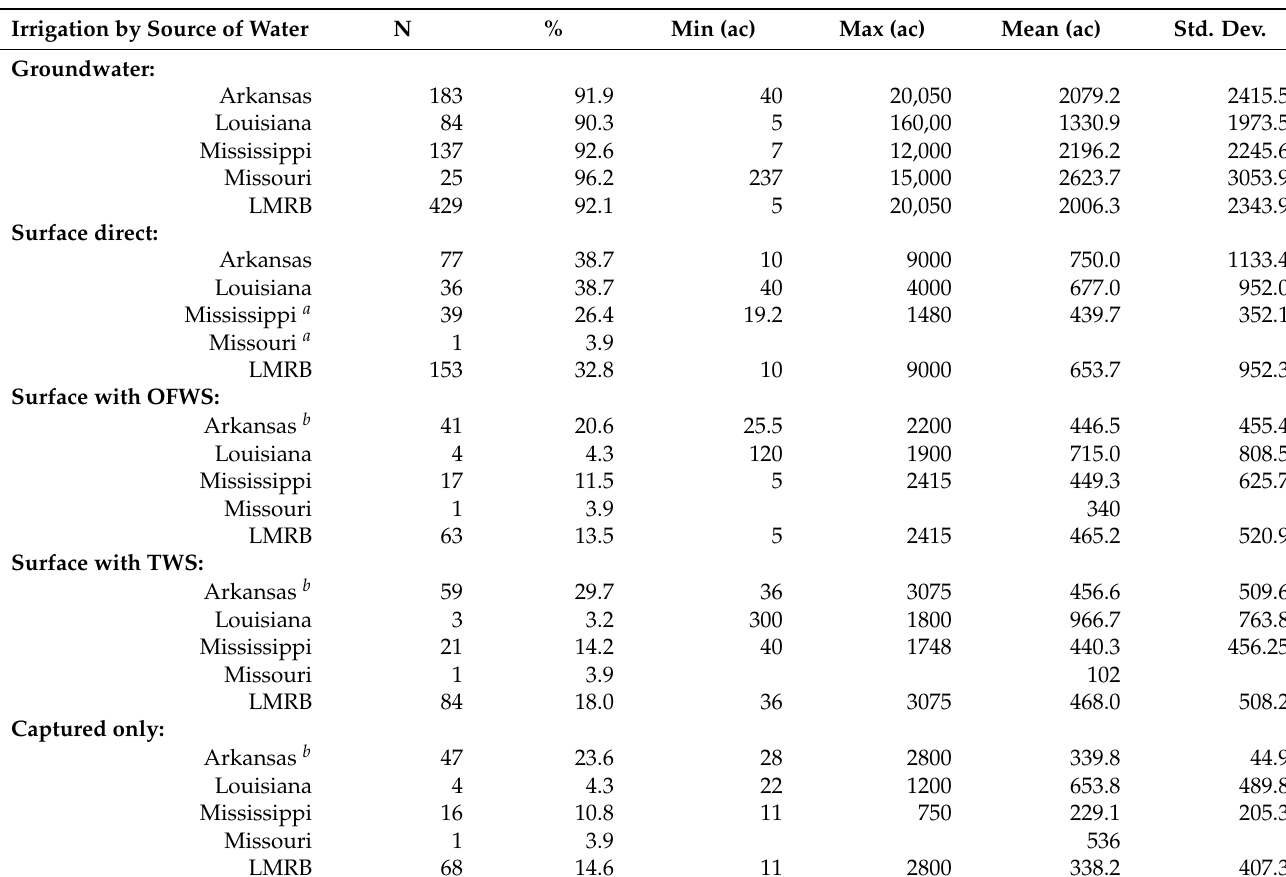
Table 5. Summary statistics of irrigation water sources in the Lower Mississippi River Basin (LMRB) in